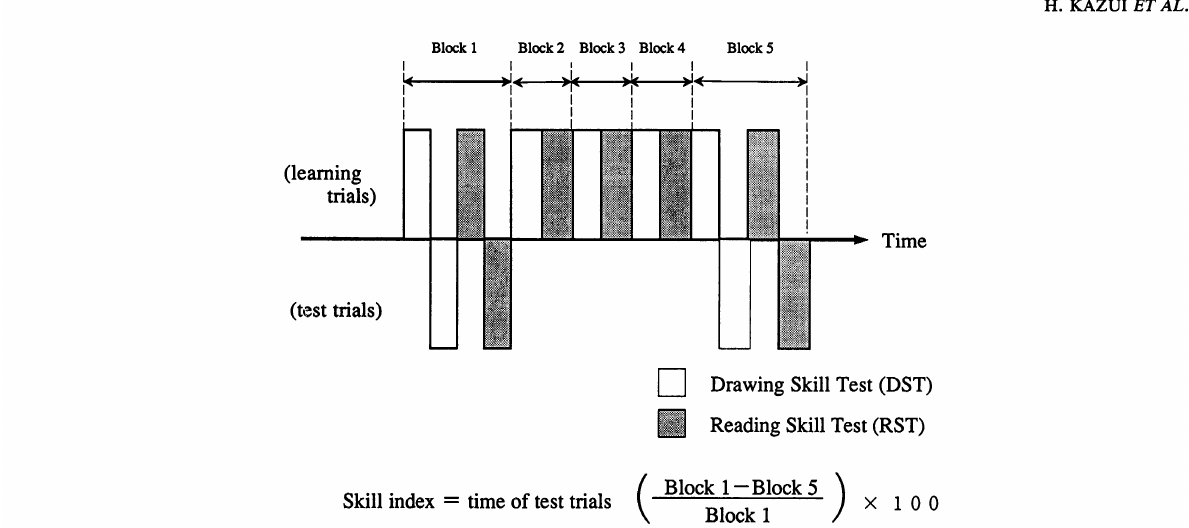
FIG. 1. Timetable for the DST and RST. Five blocks of trials were given, each consisting of learning trials for DST and RST, and test trials were added twice in the first and the fifth blocks; i.e. five learning trials and two test trials of both DST and RST were performed. We administered test trials with different materials from those used in the learning trials. Procedural learning in DST and RST was evaluated by the skill